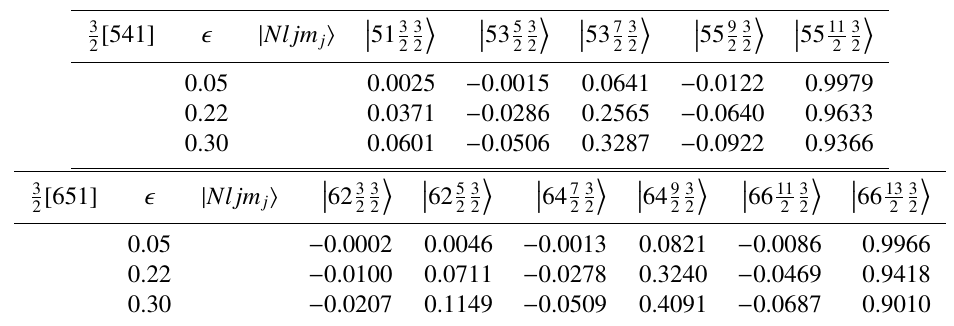
Table 4. Expansions of Nilsson orbitals K [ Nn z Λ ] in the shell model basis | Nljm j (cid:105) for three di ff erent values of the deformation (cid:15) . The Nilsson orbitals shown possess the highest total angular momentum j in their shell. The existence of a leading shell model eigenvector is evident at all deformations. Adapted from Ref. [87].